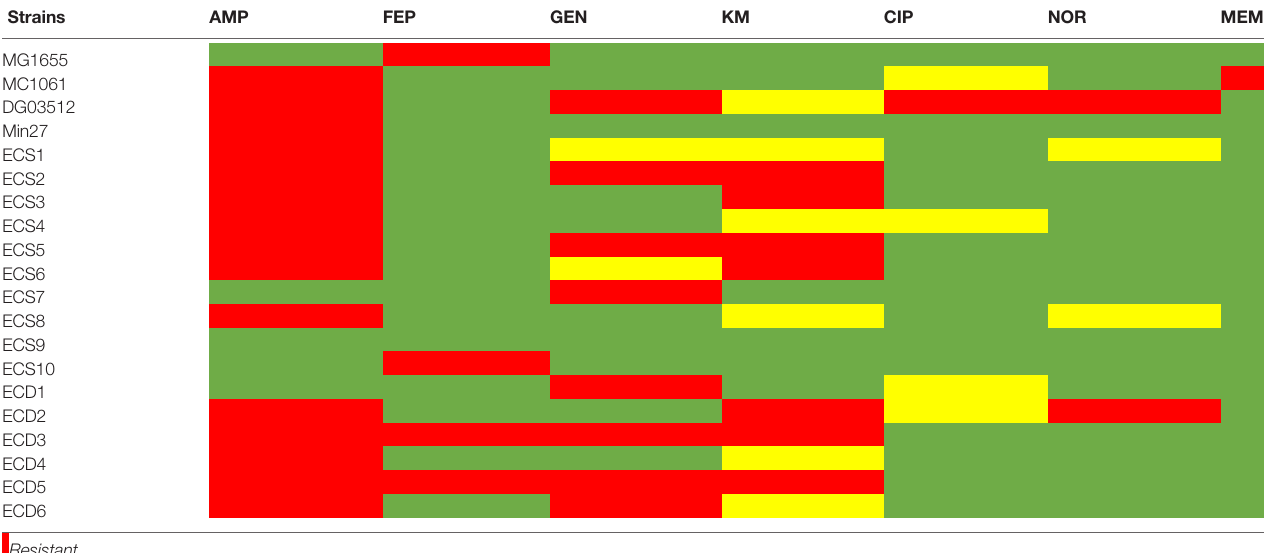
TABLE 2 | Antibiotic susceptibility pro fi les of E. coli strains used in this study. Strains AMP FEP